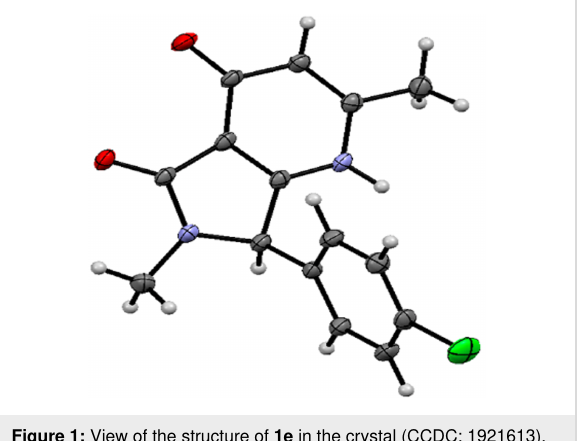
Figure 1: View of the structure of 1e in the crystal (CCDC: 1921613). Thermal ellipsoids indicate 50% probability. Solvent molecules have been omitted for clarity.